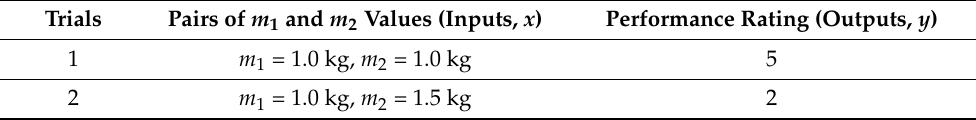
Table A2. The sample machine learning training dataset (partial list for illustration only). Trials Pairs of m 1 and m 2 Values (Inputs, x ) Performance Rating (Outputs, y